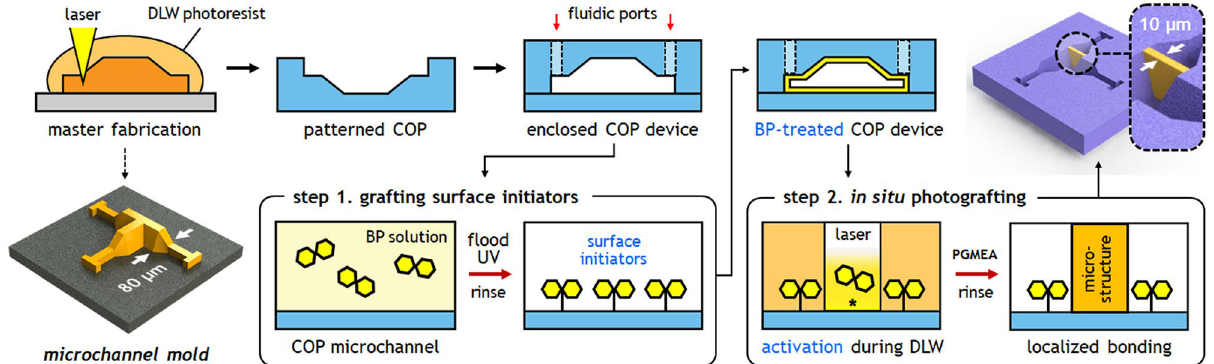
Figure 1. Two-step in situ photografting process. A microchannel mold with angled sidewalls formed via DLW is used to pattern microchannels in a COP substrate by hot embossing. The COP substrate is bonded with a thin COP film to enclose the fluidic path. Surface initiators are immobilized on the COP microchannel surface by filling the channel with BP solution, followed by UV flood exposure to promote the conversion of BP molecules into surface-bound photoinitiators (step 1). The channel is then filled with photoresist prior to direct laser writing. When the path of the DLW laser used to pattern integrated 3D microstructures coincides with the COP surface, the immobilized surface initiators are locally activated, resulting in immediate reactions with the photoresist polymer undergoing bulk polymerization (step 2). The final DLW microstructure is covalently attached to the COP